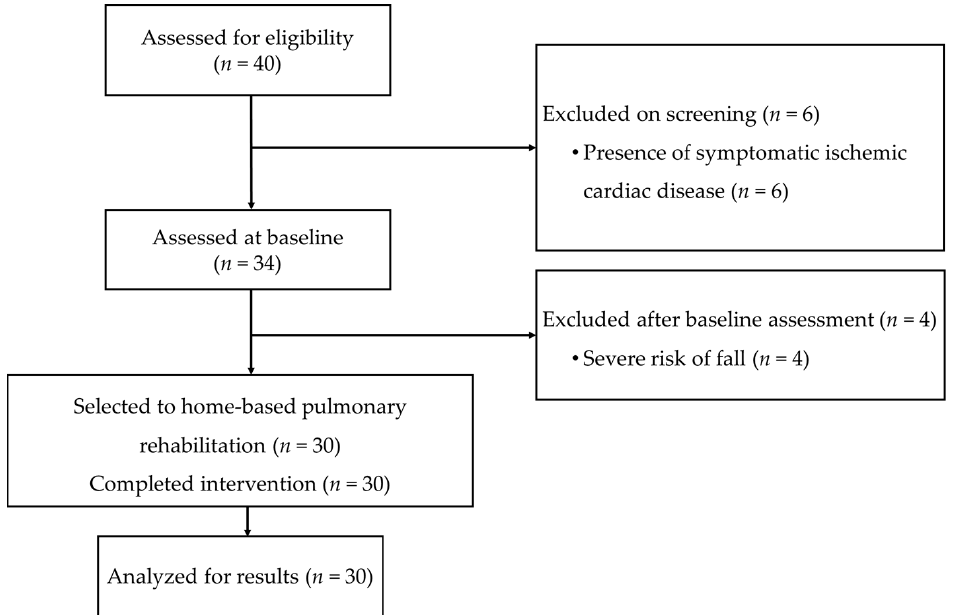
Figure 1. Flow diagram of patients through the study.